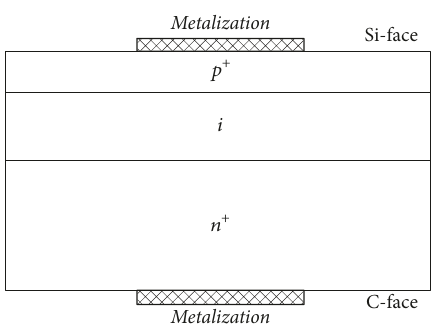
Figure 1: Schematic diode structures of p-i-n 4 H -SiC ⟨ Al ⟩